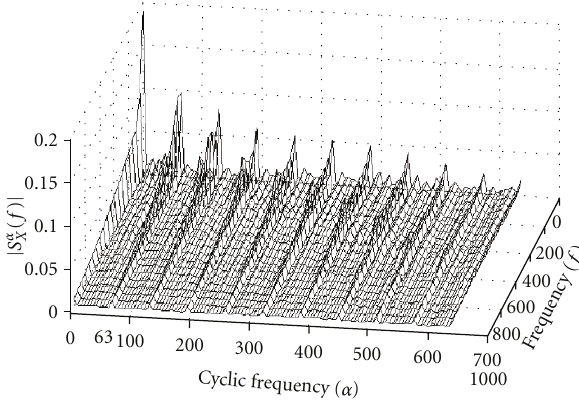
Figure 9: Cyclic power spectrum of vibratory